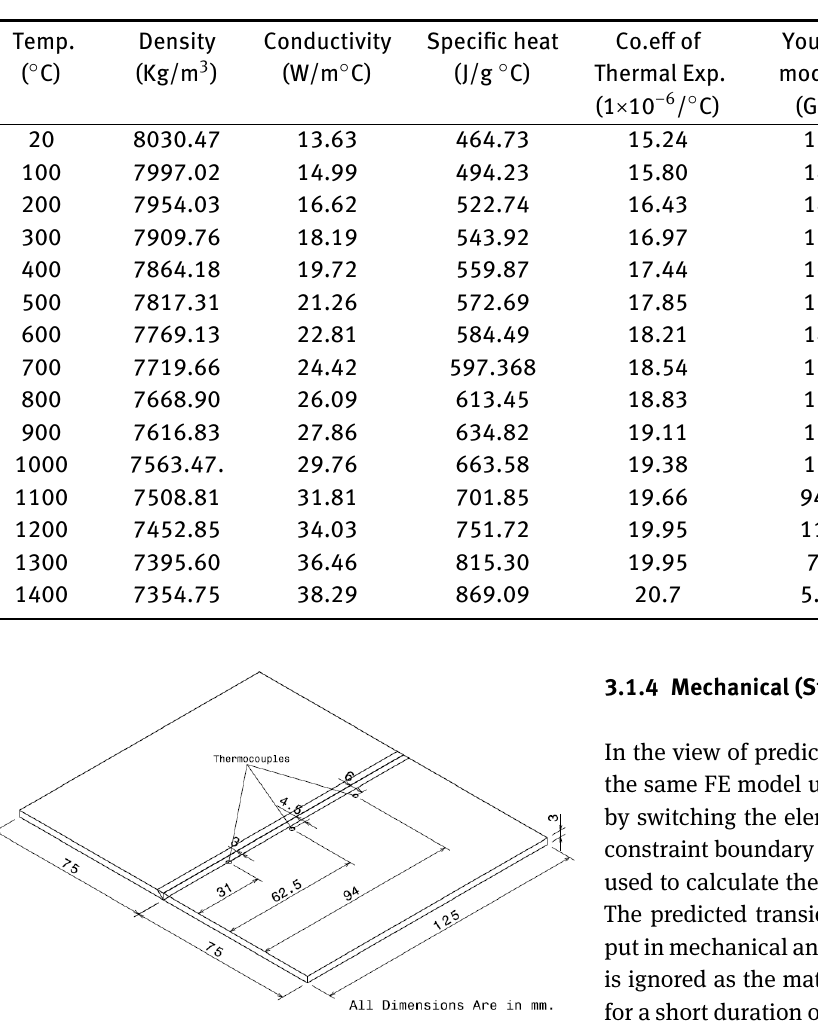
Figure 2: Schematic diagram of butt joint specimen and location of Thermocouples.